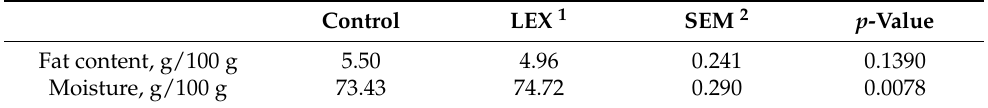
Table 4. Effect of the dietary supplementation of LEX to low-energy diets on the fat and moisture content of ground deboned breast, thigh, and drumstick of broilers in each experimental